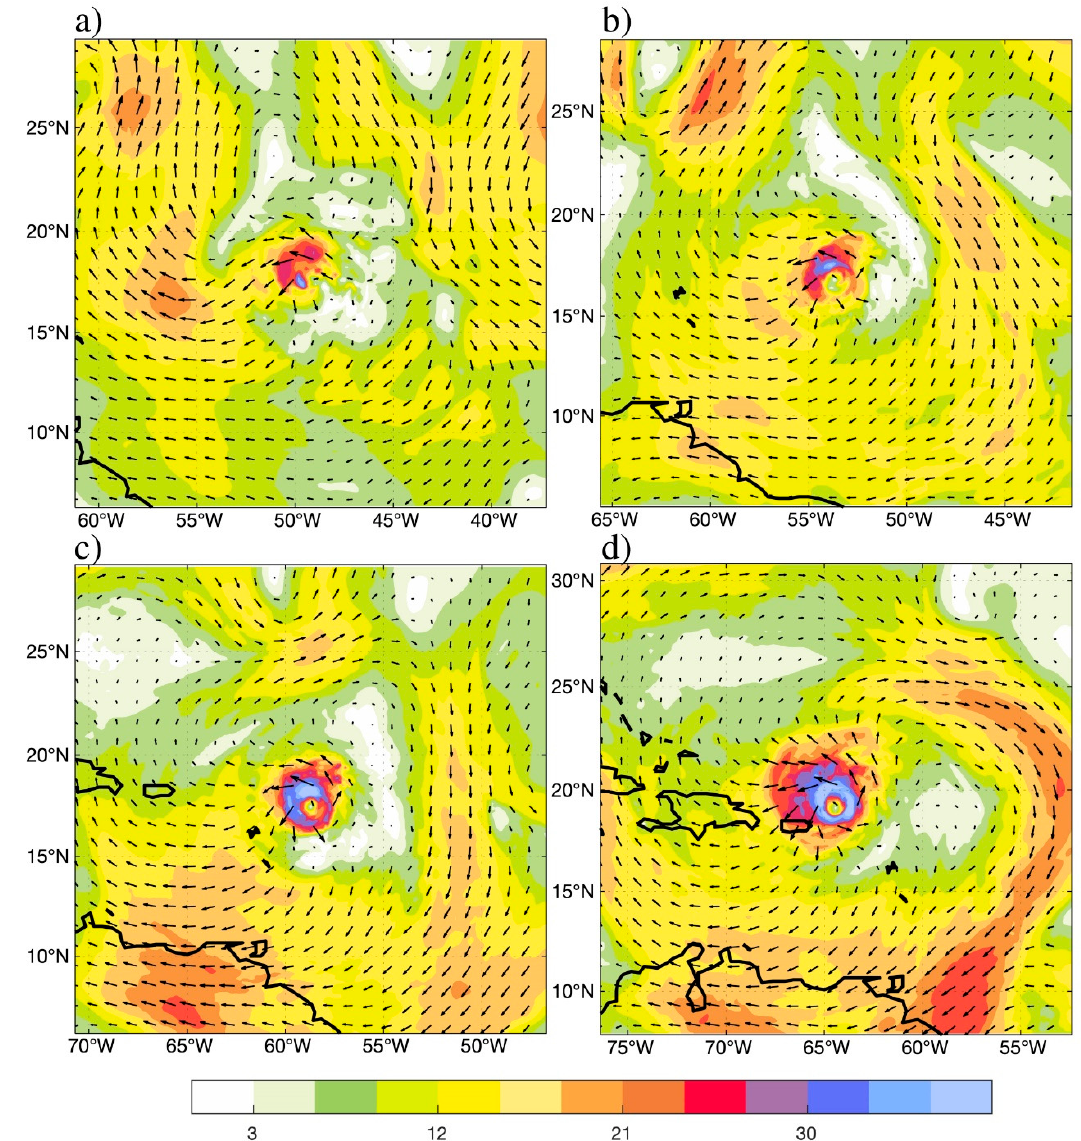
Figure 19. As in Figure 18, except z = 12,860 m wind vectors for the HWRF model forecast with ( a ) the CIMSS high-density AMV dataset included in the HWRF vortex initialization at 18 UTC 3 September, and then the HWRF model forecasts at ( b ) tau + 24 h, ( c ) tau + 48 h, and ( d ) tau + 72 h. (provided by William E. Lewis, CIMSS).